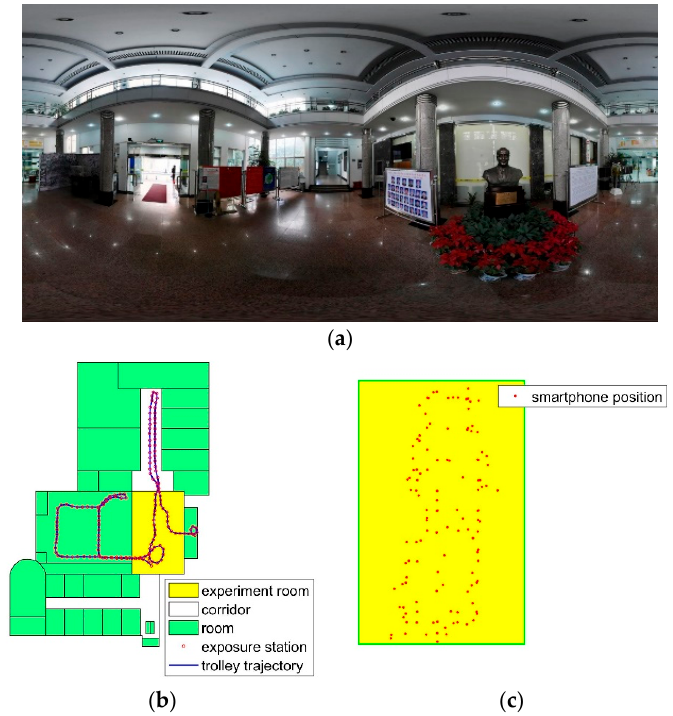
Figure 10. Data description in experiment one. ( a ) Panorama image of the room. ( b ) Database image data description. ( c ) The smartphone positions in the experiment room.